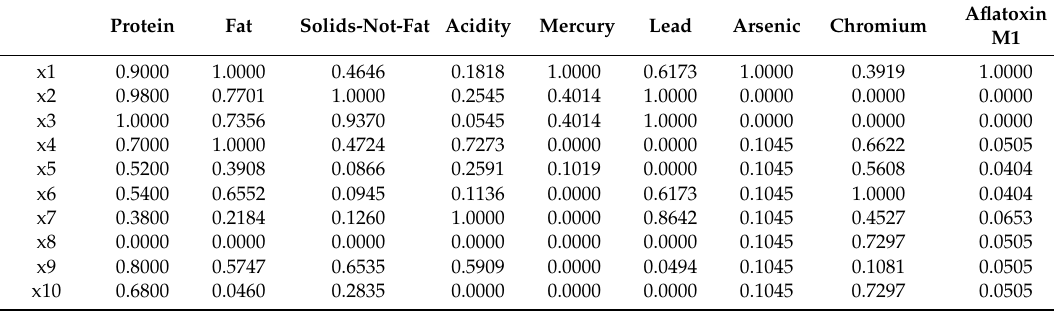
Table 3. The normalized matrix.